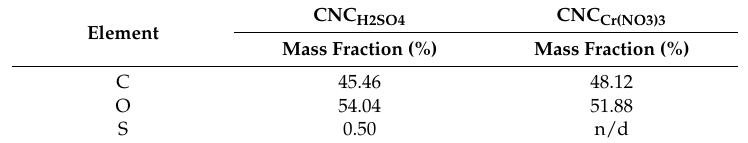
Table 1. Elemental chemical analysis and atomic fraction of CNC H2SO4 and CNC Cr(NO3)3 .